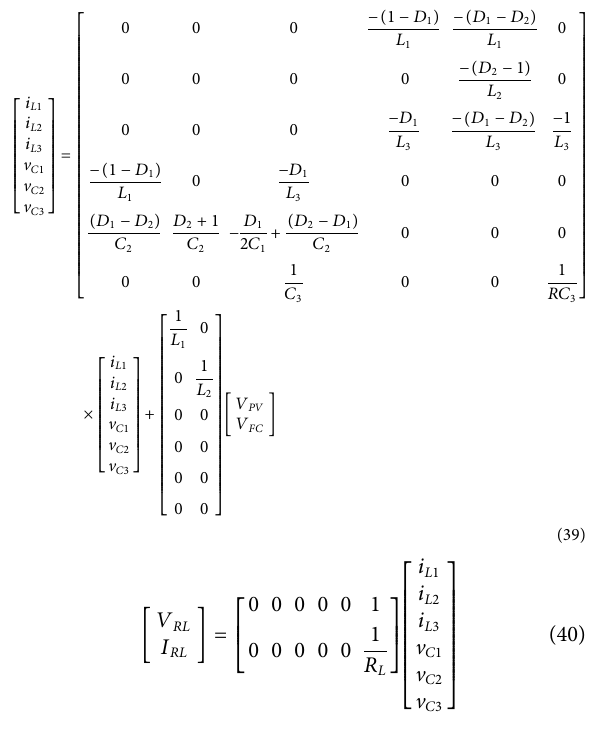
Table 1. The following section elucidates the simulation